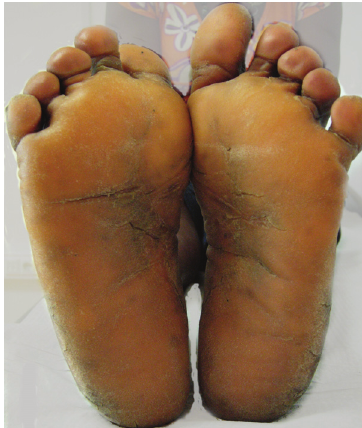
Figure 3: Improvement of plantar keratoderma after 9 months of levothyroxine therapy.